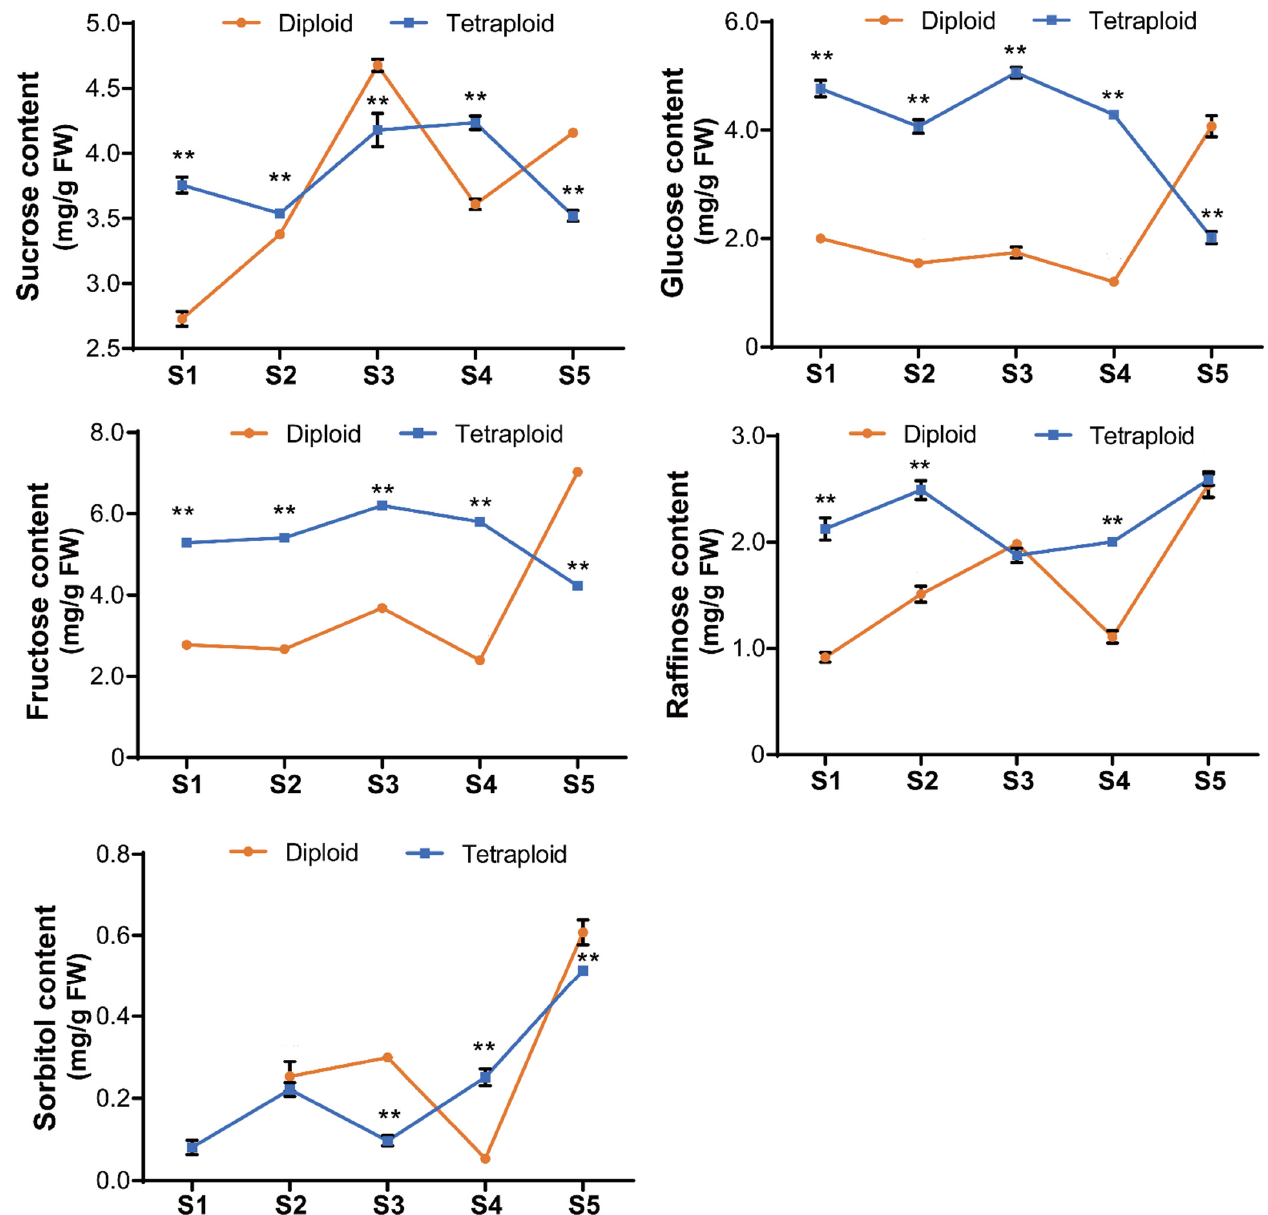
Figure 6. Nonstructural carbohydrate (NSC) contents in allodiploid and allotetraploid lilies during development. S1 ‐ S5 represent the five developmental stages. Significant differences between allodiploids and allotetraploids were determined by Student’s t ‐ test in allodiploids and allotetraploids, respectively (**, p < 0.01). The data are the means ± SDs of three biological replicates with three technical replicates.